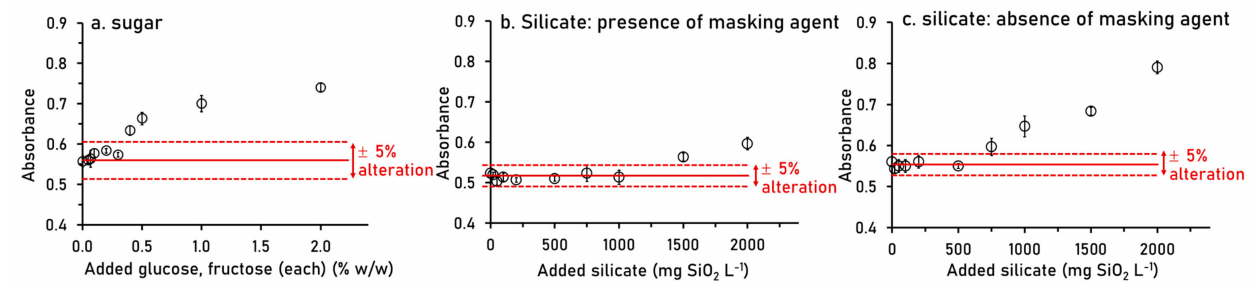
Figure 6. Results from the study for tolerance limits of the developed SIA system for ( a ) glucose and fructose on 3 ◦ Bx sucrose and for silicate on 100 mg P 2 O 5 L − 1 , ( b ) with tartaric acid masking and ( c ) without masking agent. The red solid lines mean signal of mixed standard of 3 ◦ Bx sucrose and 100 mg P 2 O 5 L − 1 . The red dashed lines mean the tolerance limit of ± 5%